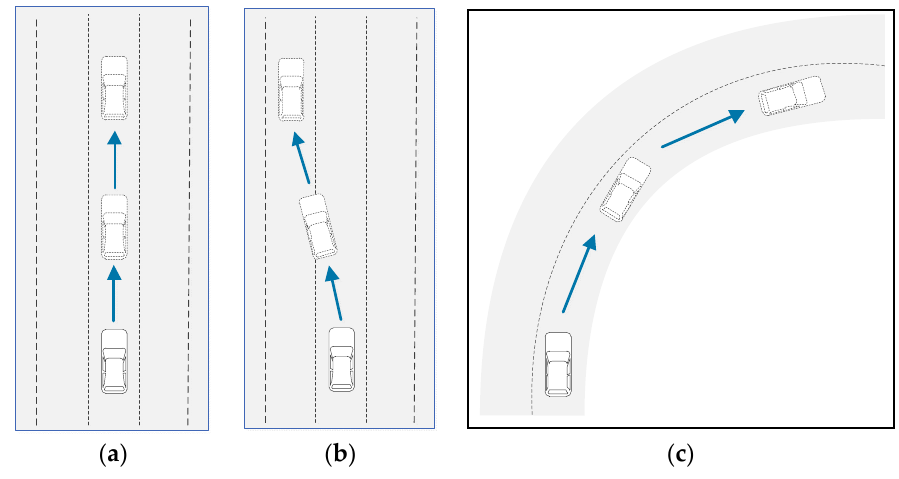
Figure 3. Typical trajectory: ( a ) normal moving; ( b ) lane change; ( c ) normal moving on a winding road. By matching the lane marks and road edges with an accurate lane-level map, the accurate position of the vehicle on the map is accessible, as well as the lane number and the road shape. The trajectories of the moving vehicles are strongly influenced by the road shape because drivers tend to follow the center line of a lane, which can be modeled with a quadratic curve, as shown in Equation (2).